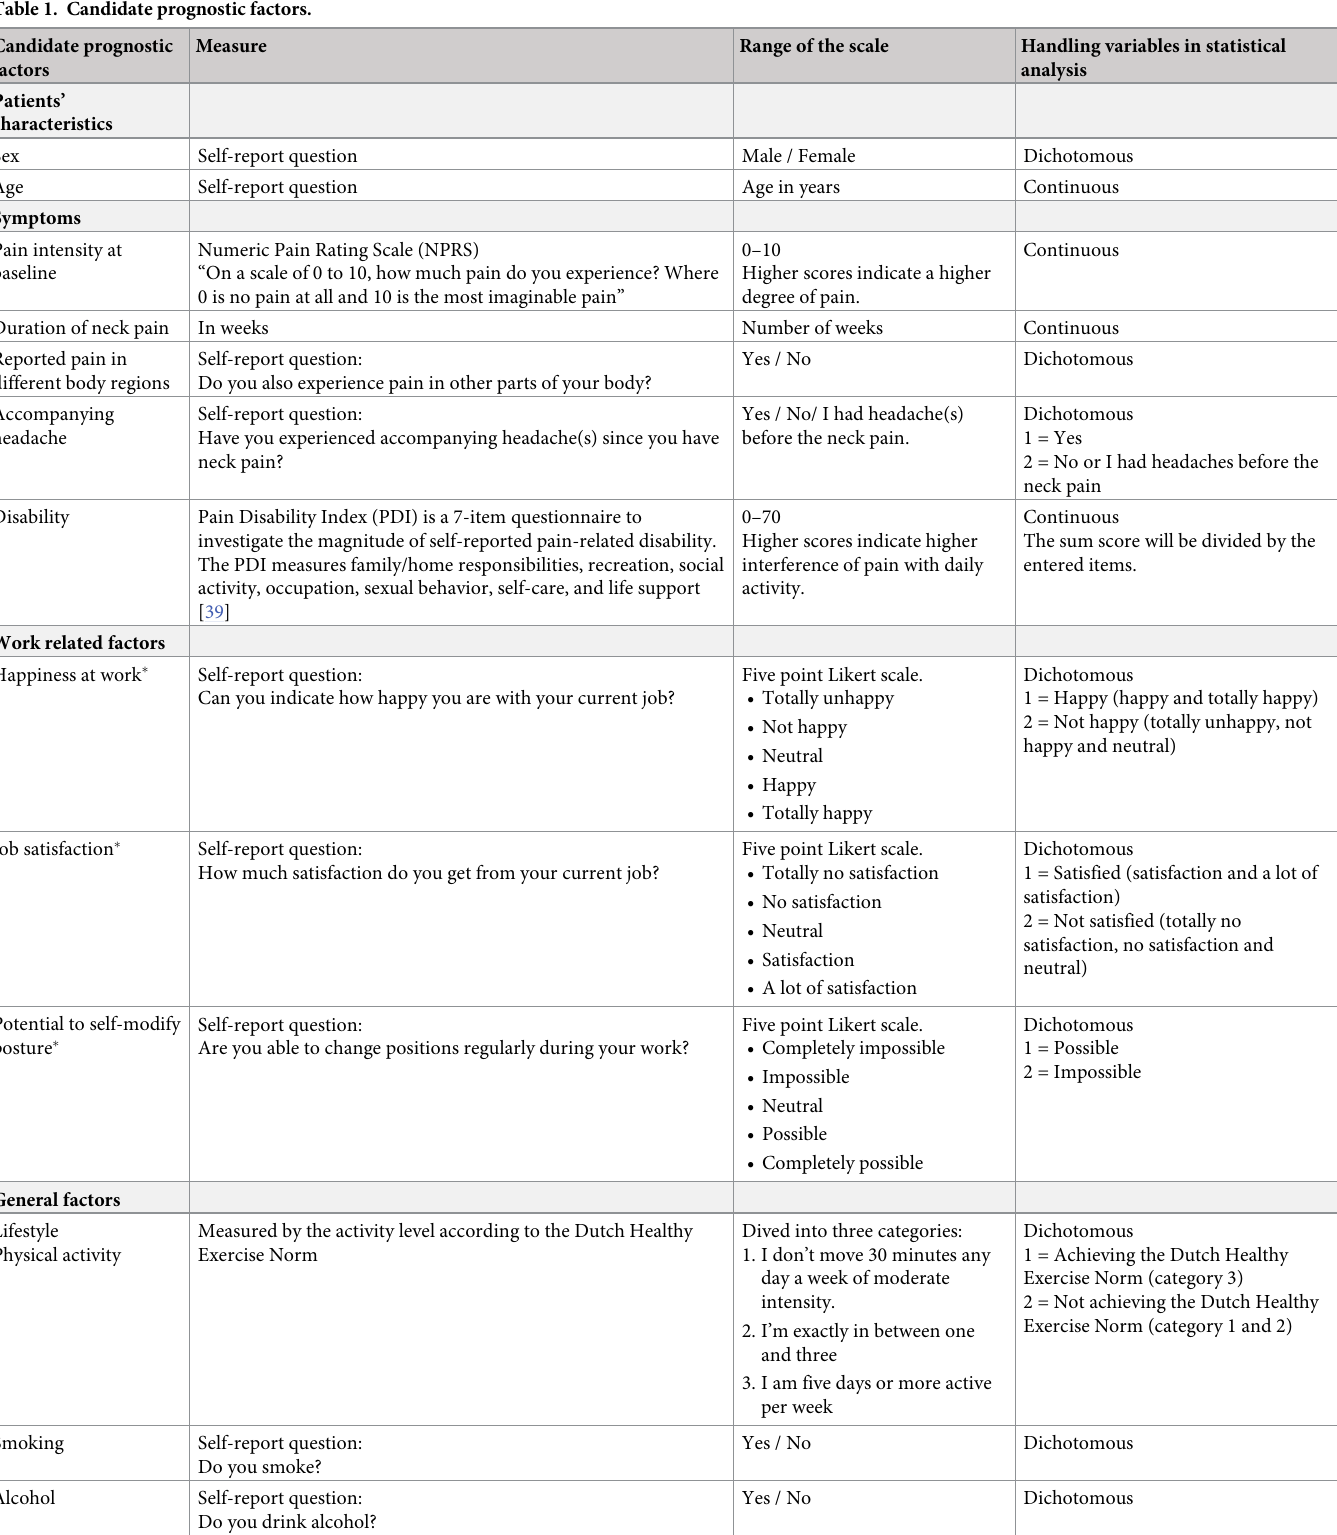
Table 1. Candidate prognostic